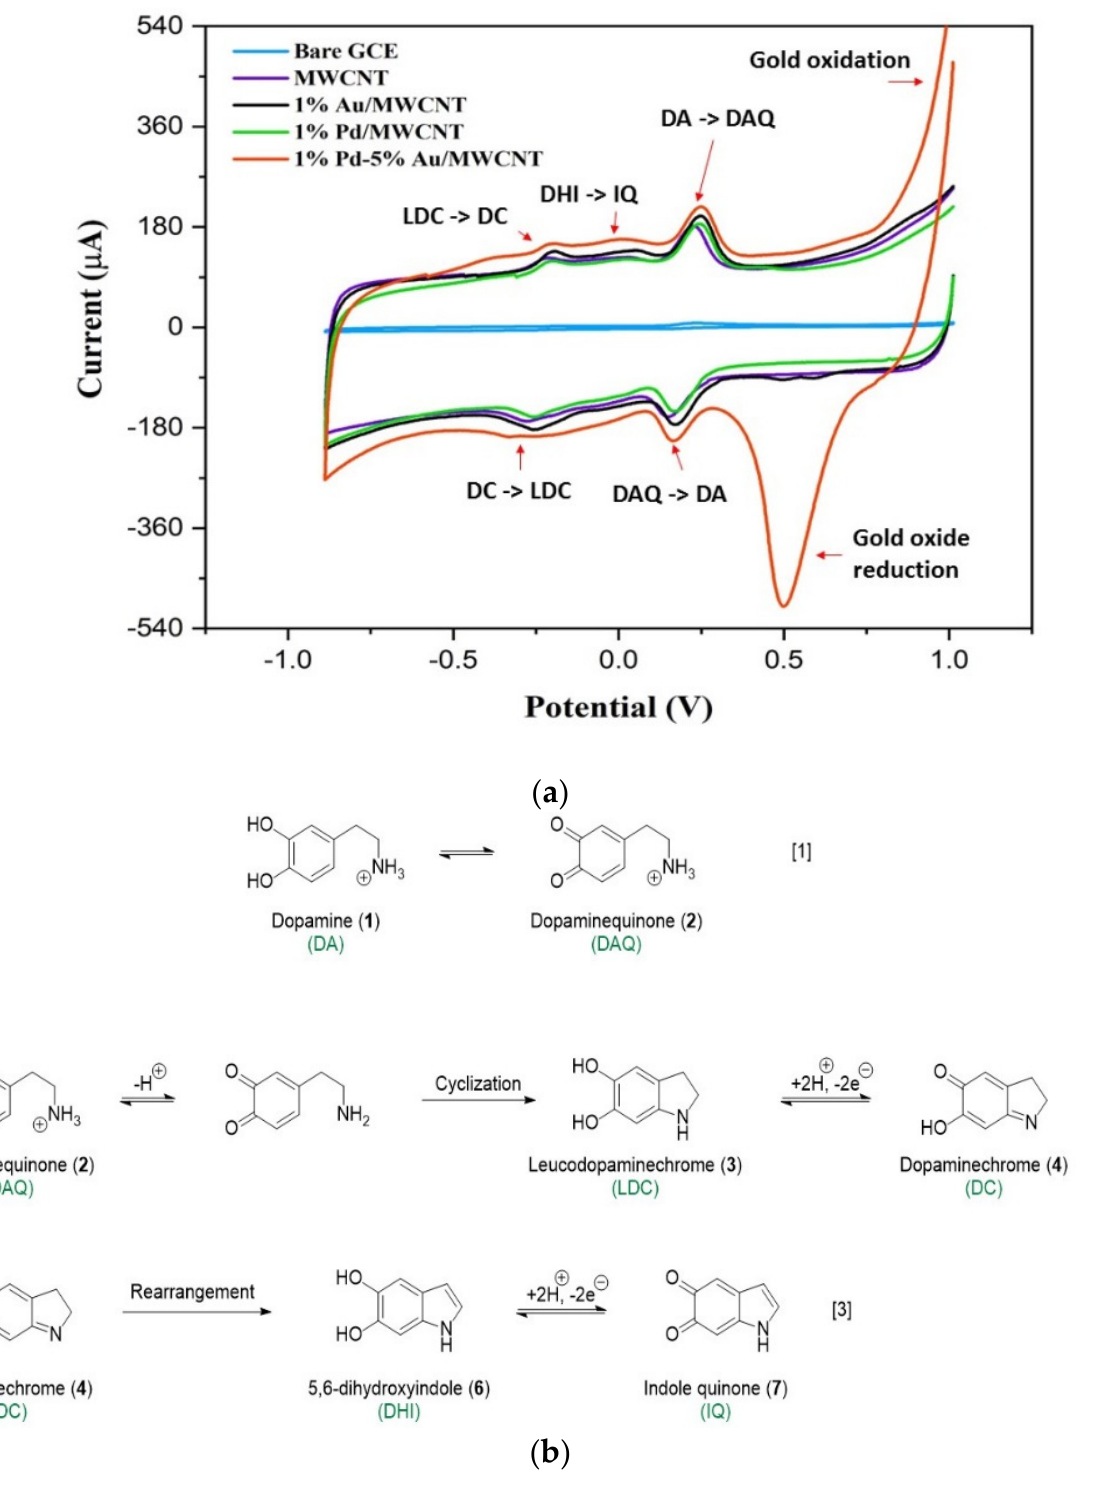
Figure 7. ( a ) CV curves of the various kinds of sensing material samples. ( b ) Oxidation-reduction reaction mechanisms of DA and relative compounds.